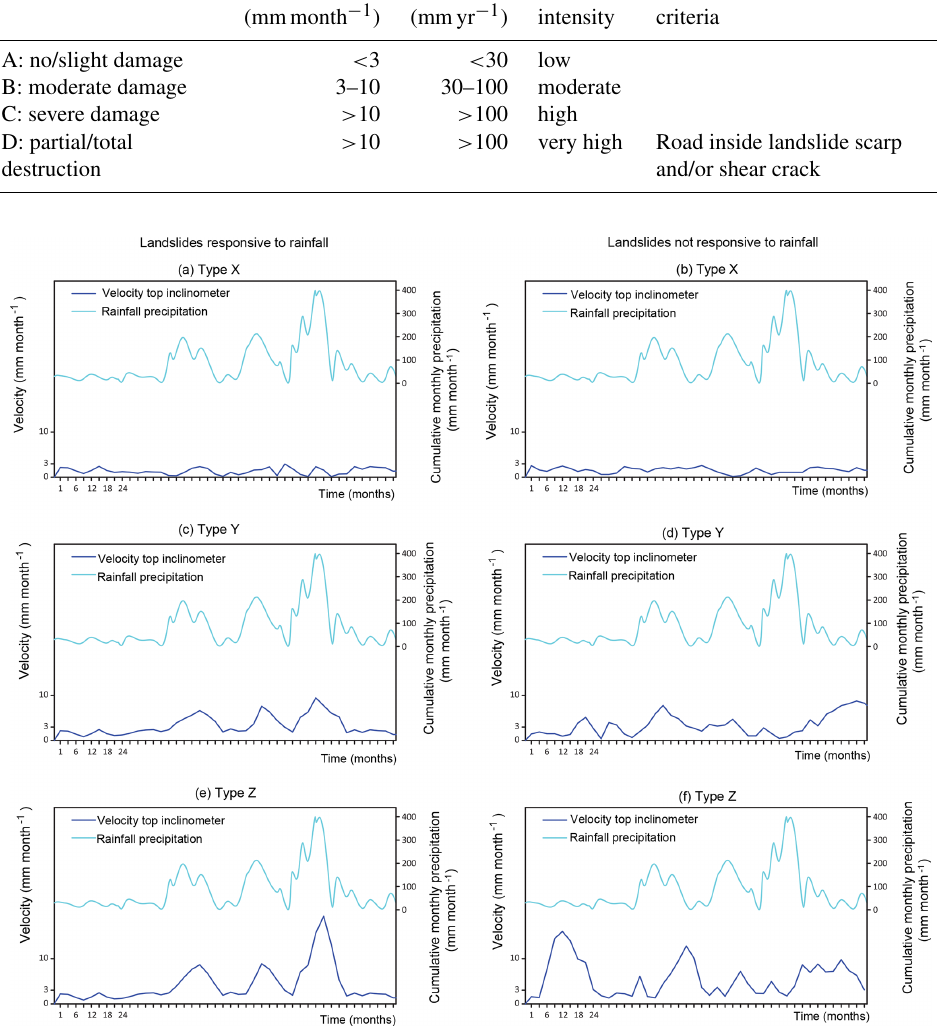
Figure 6. Patterns of movement for landslides responsive (a, c, e) and not responsive (b, d, f) to